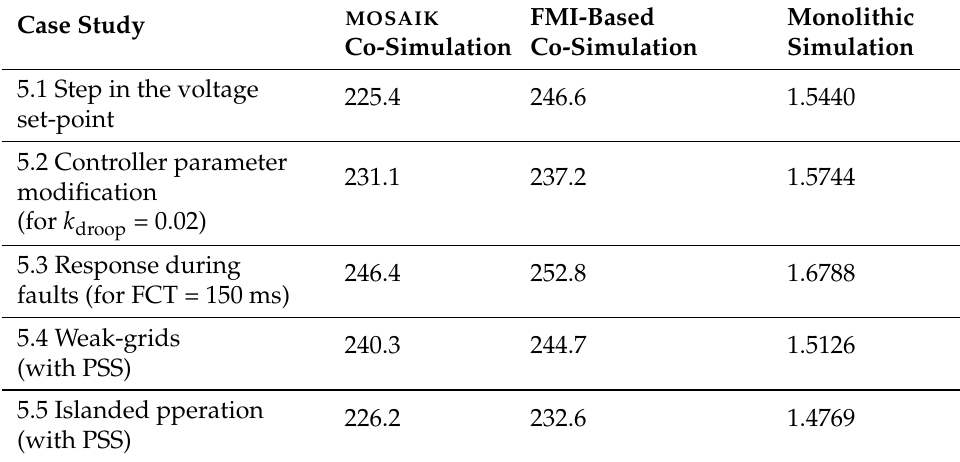
Table 2. Execution times of the simulations [s] for the case studies of Sections 5.1–5.5. (Intel Xeon W-2123, 3.6 GHz, 8 GB